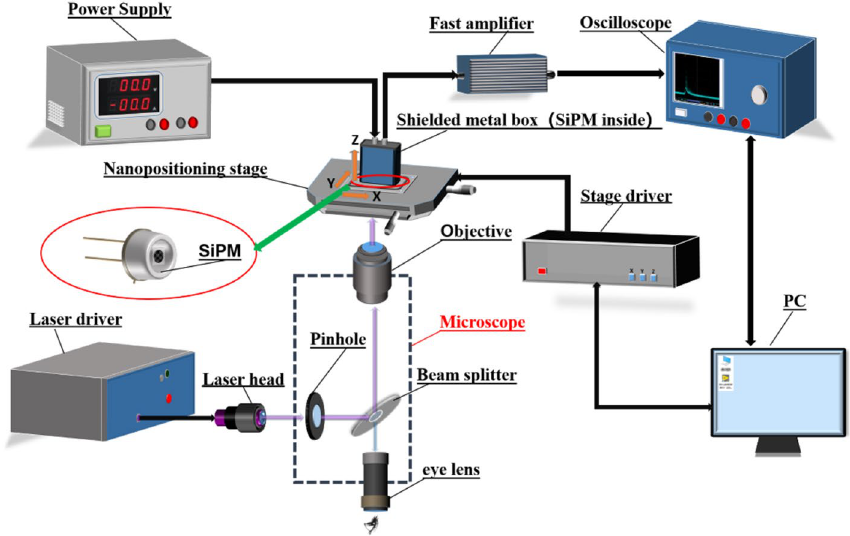
Figure 1. Schematic diagram of the experimental setup. SiPM silicon photomultiplier, PC personal computer; the dotted box represents the microscope.